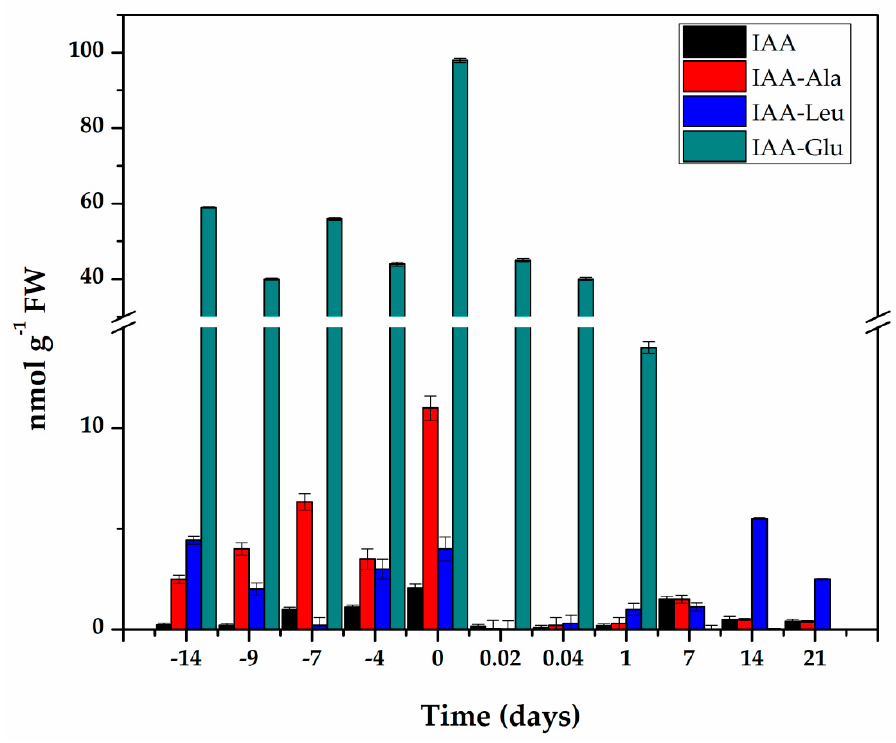
Figure 3. Content of IAA and its conjugates during pre-treatment and induction of SE in C. canephora . Samples of 100 mg of leaf tissue were collected (Days − 14, − 9, − 4, and 0). Samples were also collected at 0.02, 0.04, 1, 7, 14, and 21 days after SE induction. Samples were analyzed as described in Materials and methods. All analyses were carried out with three biological replicates from at least two different experiments. The bars represent the standard error ( n = 3).